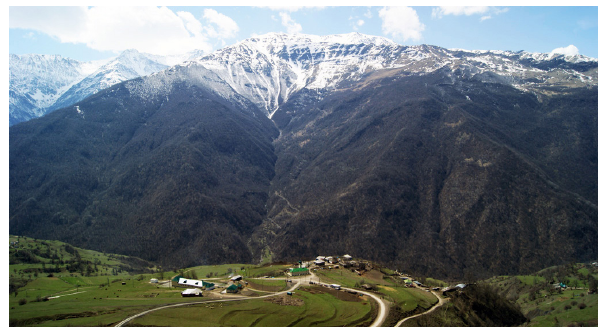
Figure 3. Typical terrain in the Veduchi region.